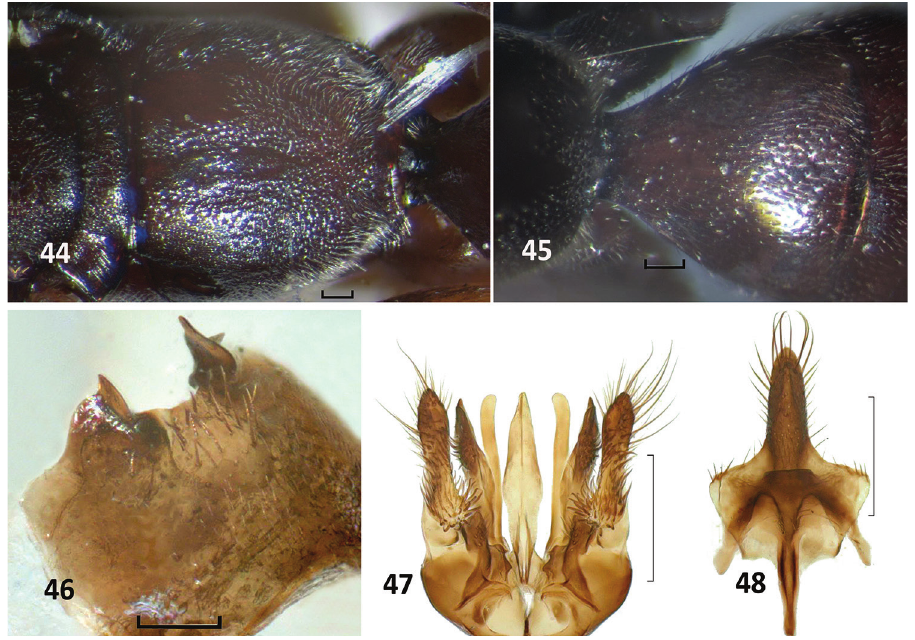
Figures 44–48. Nipponodipogon sudai Shimizu, paratype. 44 Mesoscutellum, metanotum, metapost- notum, propodeum and base of T1, dorsal view 45 T1, dorsal view 46 S6, ventral view 47 Genitalia, ventral view 48 Hypopygium and S7, ventral view 44 Female 45–48 Male. Scale bars 0.1 mm for 44–46 ; 0.25 mm for 47, 48